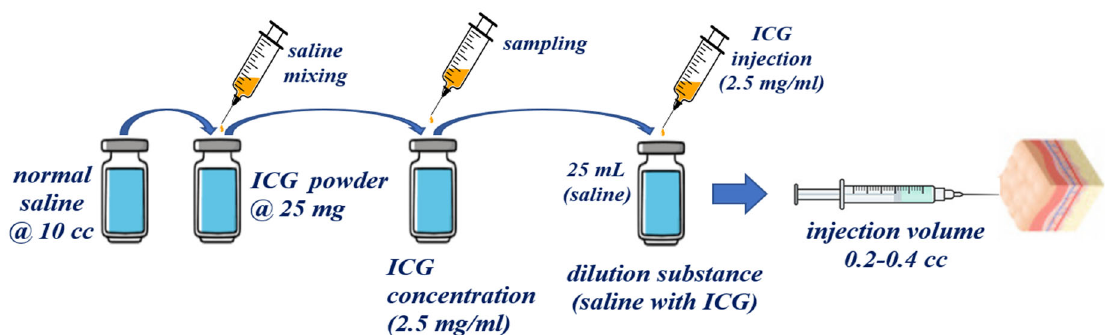
Figure 13. Phantom reagent production procedure.